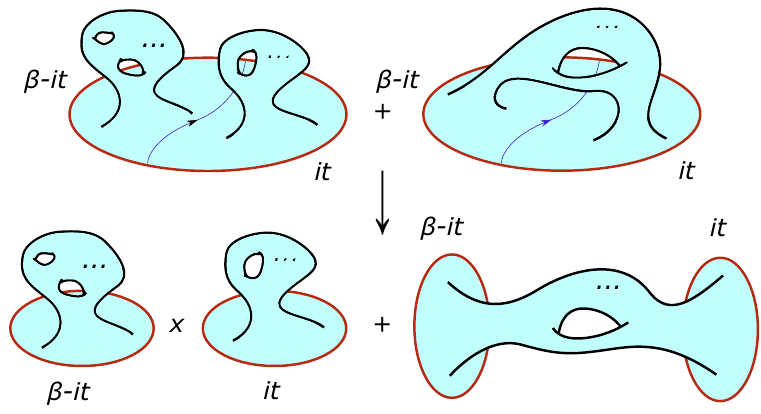
Figure 19 . Late time reduction of the boundary two point function to the spectral form fac- tor (D.11). The Wilson line pinches o(cid:11) distinct regions.